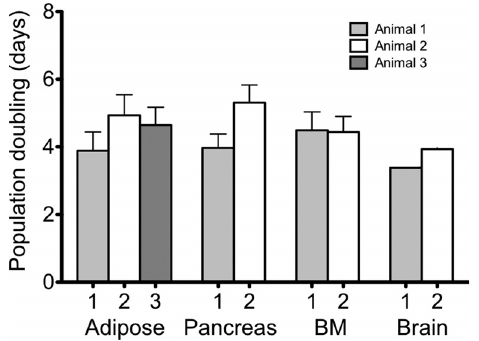
Figure 2 - Mean values of population doublings. Viable cells were counted at each passage (P3 to P8) of cultures derived from adipose tissue (n = 3), pancreas (n = 2), bone marrow (BM, n = 2) and brain (n = 2), for determination of population doubling times.